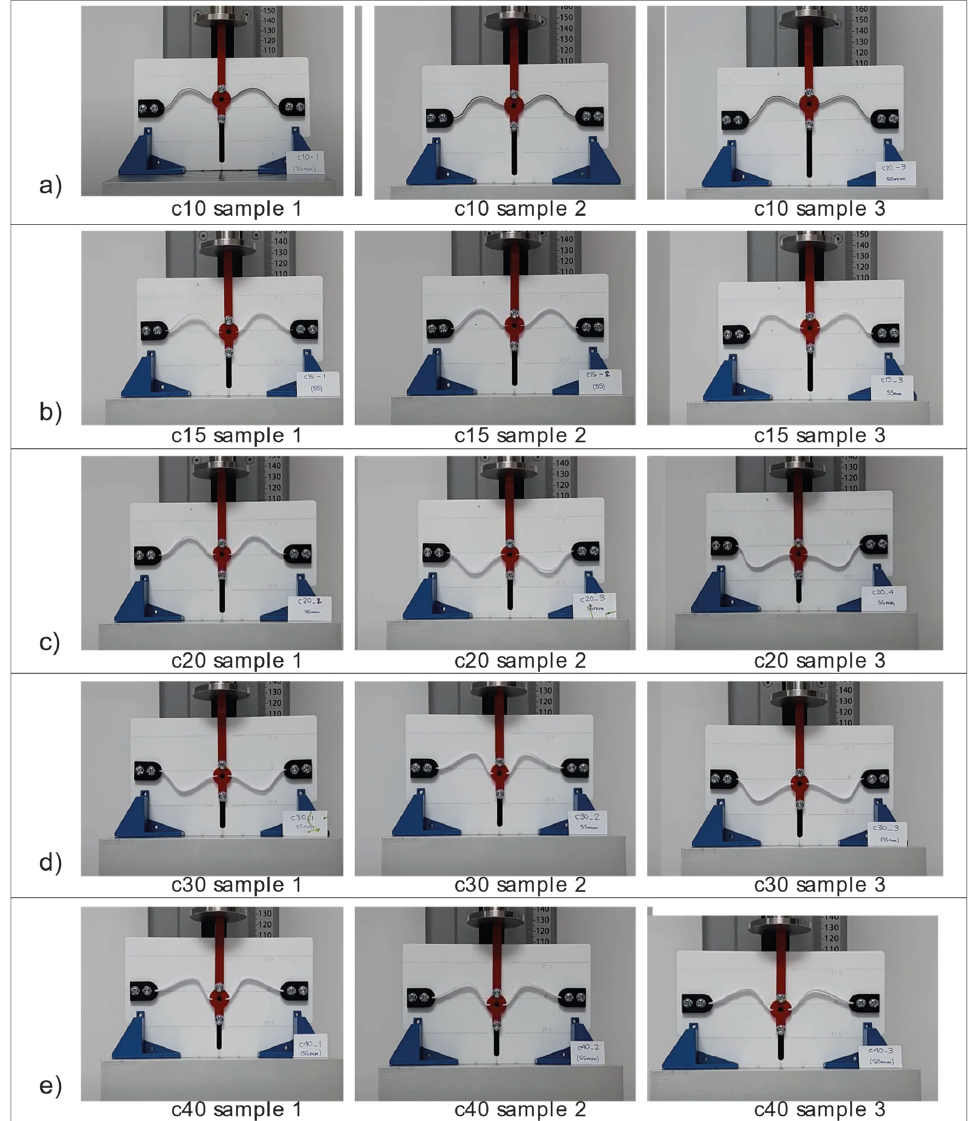
Figure 10. Image of samples used for the “Performance by thickness” experiments, at their snap- through points. ( a ) Samples of c10 flexure beams (0.25 mm) ( b ) Samples of c15 flexure beams (0.38 mm) ( c ) Samples of c20 flexure beams (0.50 mm) ( d ) Samples of c30 flexure beams (0.50 mm) ( e ) Samples of c40 flexure beams (1.00 mm).